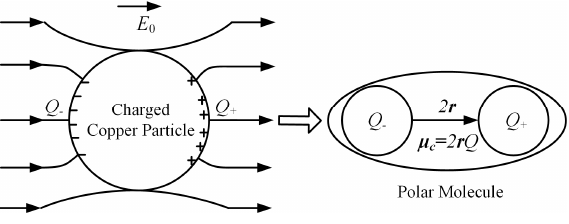
Figure 8. Charged copper particle modeled as a polar molecule.